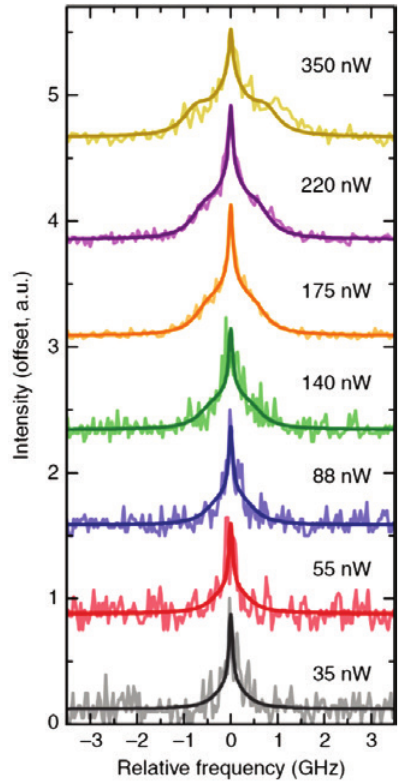
Figure 6: Excitation-dependent resonance fluorescence emission spectra and photon autocorrelation function under cw excitation by a state-of-the-art high- β QD microlaser. Increasing excitation power leads toward a Mollow-triplet like emission spectrum. Reprinted figure from